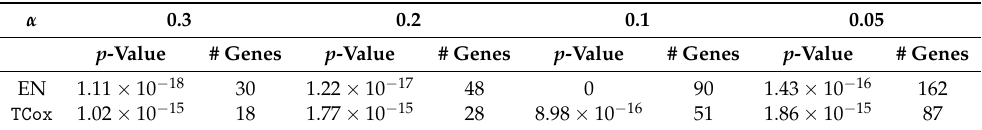
Table 2. Summary of the results obtained from Cox models using the two regularizations, EN and TCox . α controls the sparsity of the model (0.05 < α < 0.3). # genes—number of genes selected. All results are presented as mean values of the 100 runs tested. α 0.3